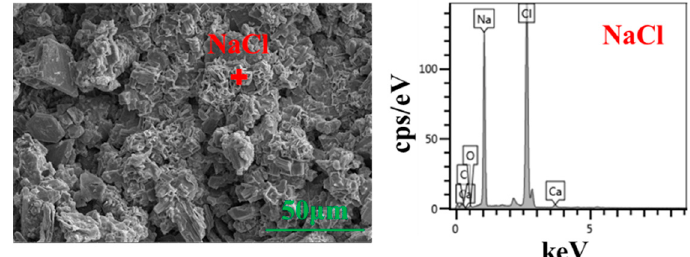
Figure 5. Energy dispersive spectrometry (EDS) analysis of specimens exposed to NaCl. Magnification factor: 2500×; accelerating voltage: 10.00 kV; and working distance: 6.0 mm.